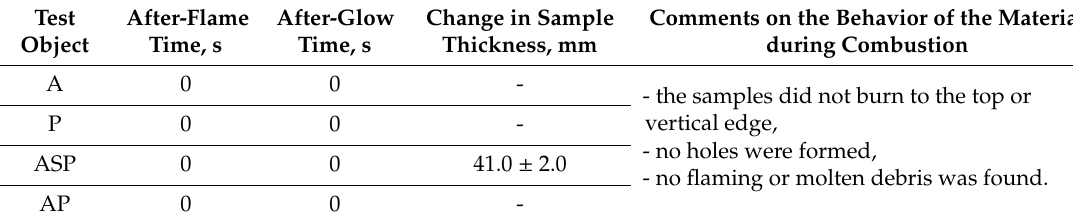
Table 6. Test results of resistance to ignition in accordance with EN ISO 15025:2016